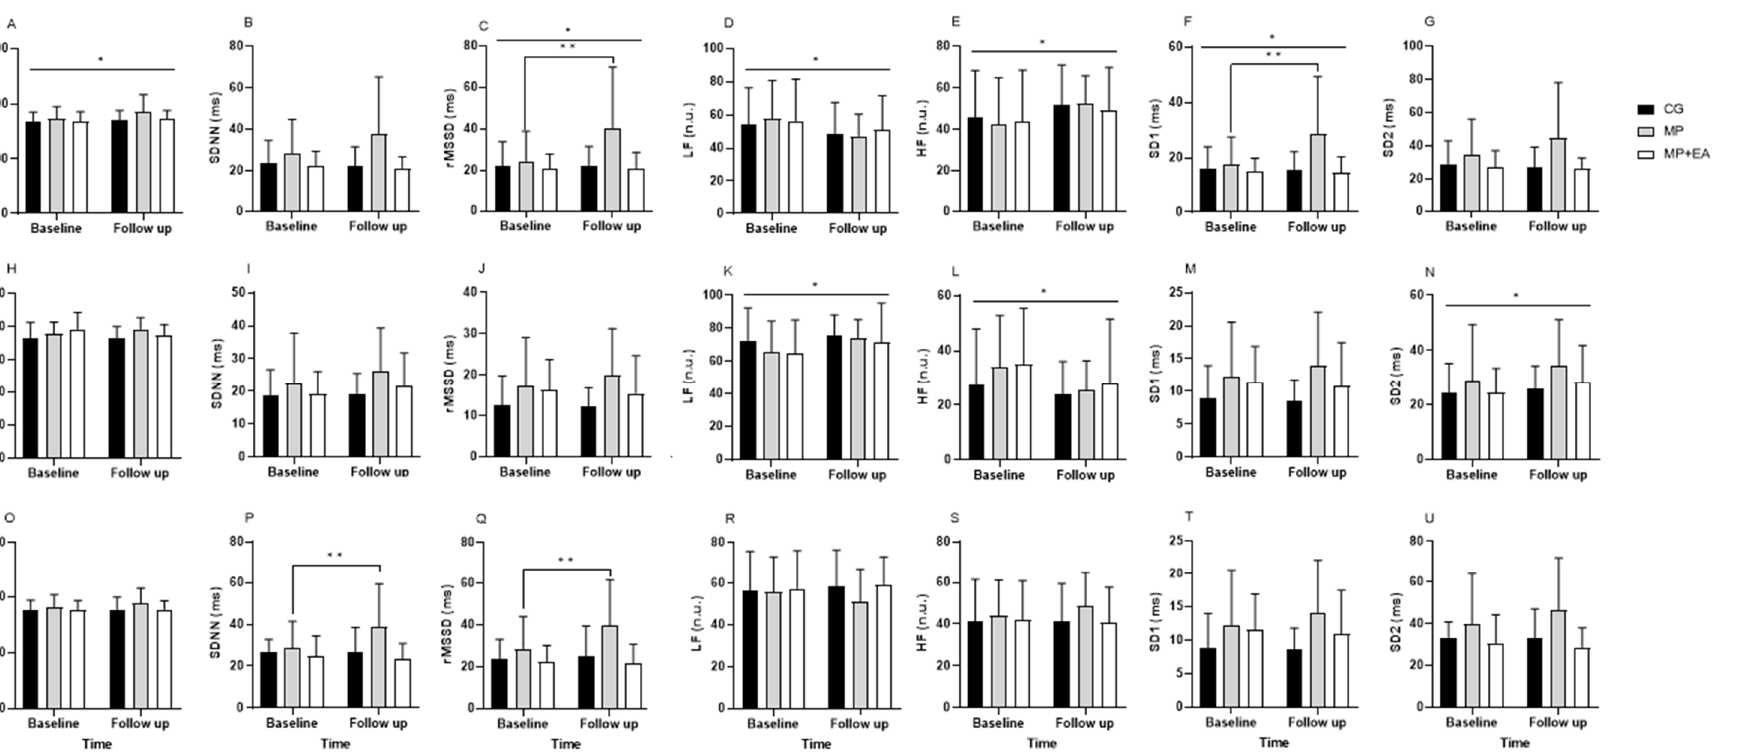
Figure 1. Comparisons for heart rate variability indices in the three moments analyzed, excluding participants who used beta-blockers ( n = 41). ( A – G ) Supine moment at rest, ( H – N ) standing moment, and ( O – U ) recovery moment. CG: Control Group; MP: Mat Pilates Group; PM+AE: Mat Pilates Supplemented with Aerobic Exercise Group. R-R interval: the average of all normal R-R intervals; SDNN: standard deviation of R-R intervals; rMSSD: the square root of the mean squared differences in successive R-R intervals; LF: low-frequency band; HF: high-frequency band; SD1: variance of R-R intervals in a short time scale; SD2: variance of R-R intervals in a long time scale. * Indicates within-group effect ( p < 0.05). ** Indicates MP group difference ( p < 0.05).